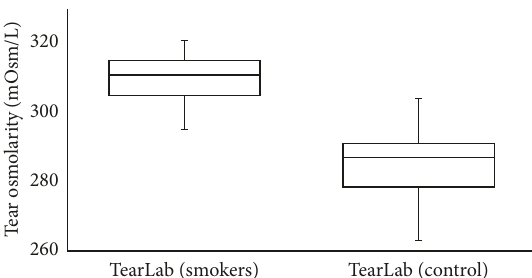
Figure 2: Side-by-side boxplot for tear osmolarity measurements using the TearLab system in the study (smokers) and control (non- smokers) groups.